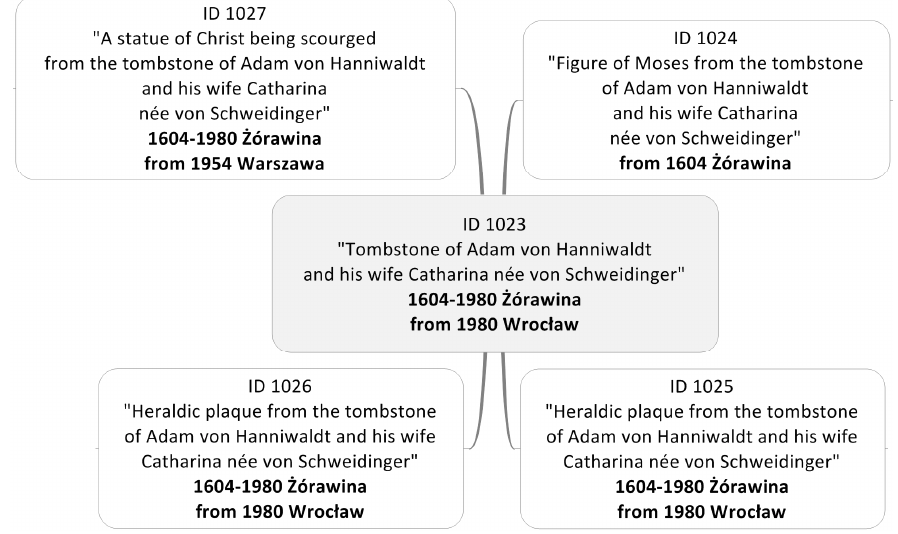
Figure 1. An example of a monument from Ż órawina and its scattered parts (source: own work).